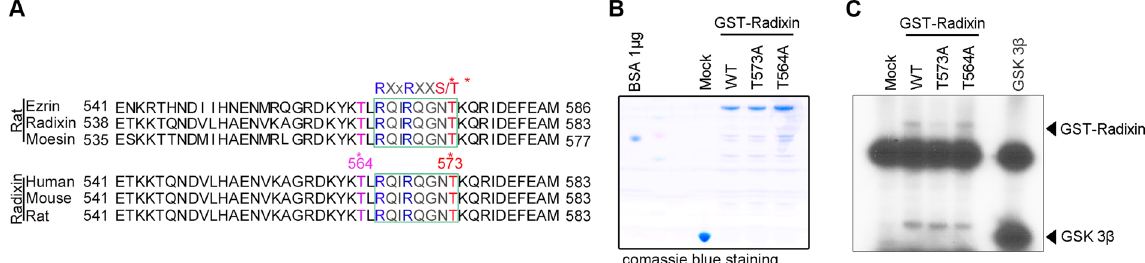
Figure 2. Akt phosphorylates radixin at the C-terminal threonine. ( A ) Comparison of species and rat ERM proteins demonstrate significant homology. ERM proteins share a C-terminal actin-binding domain and an N-terminal FERM domain. The C-terminal residue of a radixin contains a consensus sequence for Akt- mediated phosphorylation. ( B ) Purified bacterial expressing GST-tagged proteins were analyzed by SDS- PAGE followed by coomassie staining. ( C ) An in vitro Akt kinase assay was performed with purified active Akt and purified GST fusion proteins of radixin − WT, phosphor-ablation mutant radixin–T573A and T564A. GSK3 β fusion and GST proteins were used as positive and negative controls, respectively. Arrows indicate phosphorylated GST-radixin proteins. The image shown is representative of at least three independent experiments. The uncropped blot images are shown in Supplementary Fig